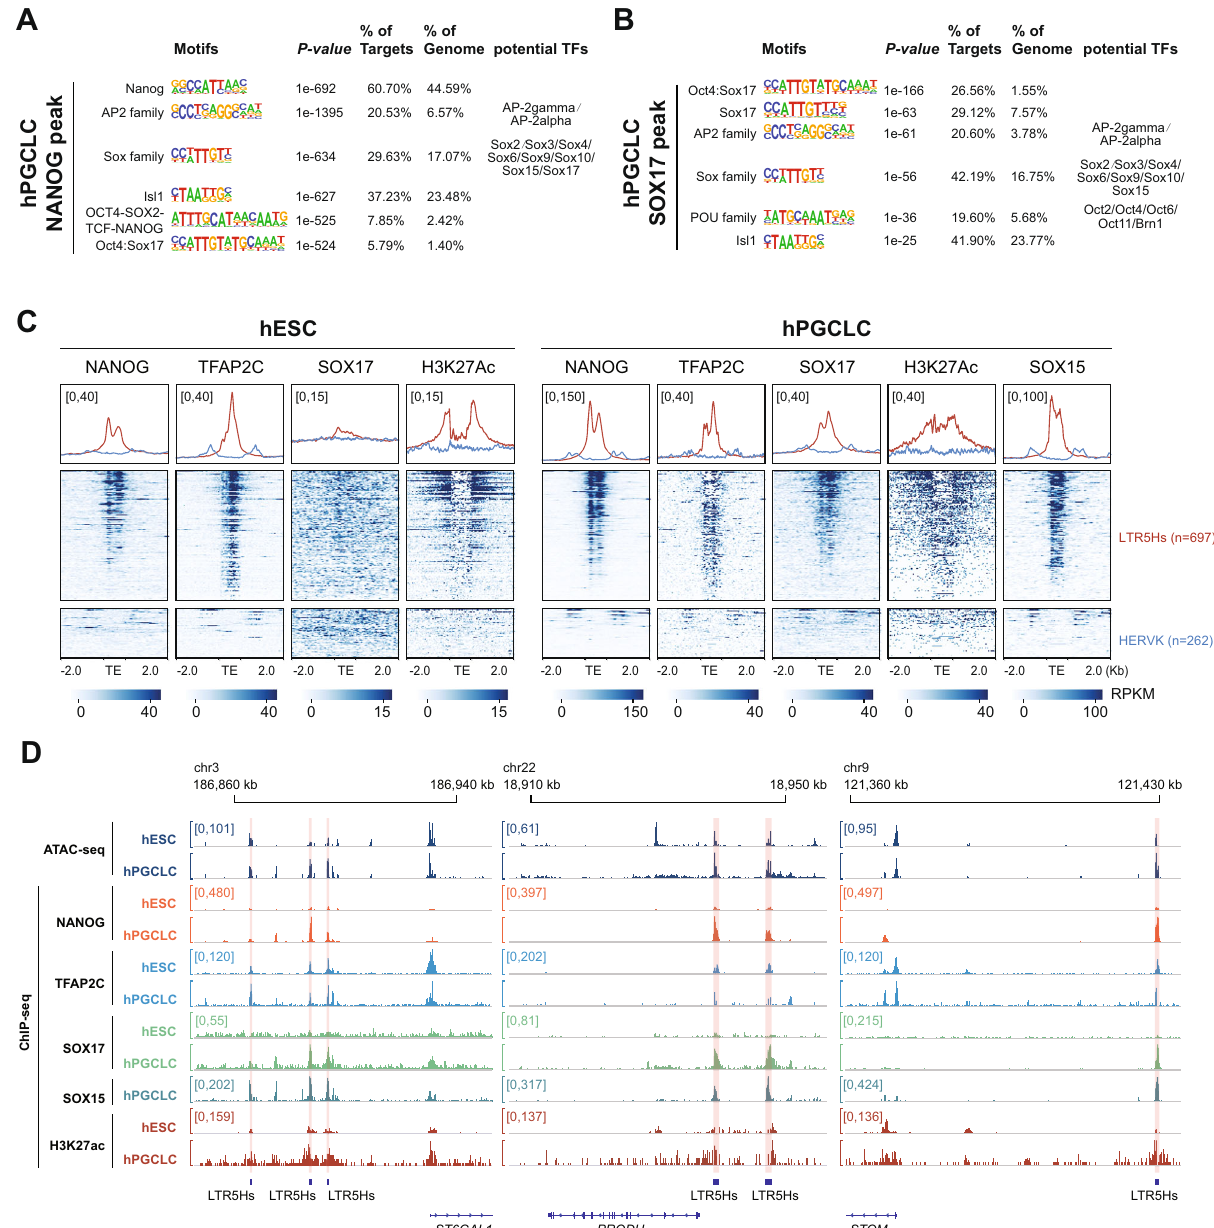
Fig. 4 LTR5Hs may serve as TEENhancers in hPGCLCs. A , B Top enriched motifs within NANOG ( A ) and SOX17 ( B ) ChIP-seq peaks in hPGCLCs. Hypergeometric test is performed using Homer 77 . C Heatmaps and metaplots of NANOG, TFAP2C, SOX17, and H3K27ac ChIP-seq signals in hESCs and hPGCLCs, and SOX15 CUT&Tag-seq signals in hPGCLCs over all LTR5Hs ( n = 697) and HERVK ( n = 262). D Screenshots for ATAC-seq signals, NANOG, TFAP2C, SOX17, and H3K27ac ChIP-seq signals in hESCs and hPGCLCs, and CUT&Tag-seq signals for SOX15 over LTR5Hs TEENhancers and their potential target genes ( ST6GAL1 , PRODH , and STOM